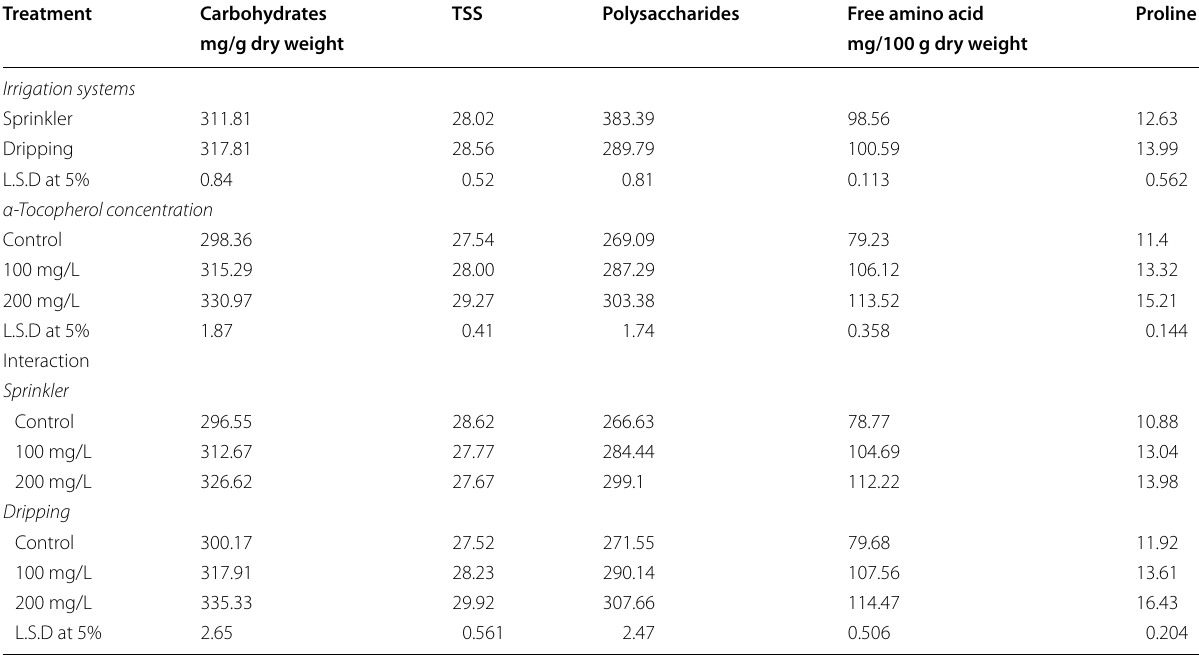
Table 4 Effect of irrigation system and α-tocopherol foliar spray on TSS, polysaccharides, total carbohydrate (mg/g